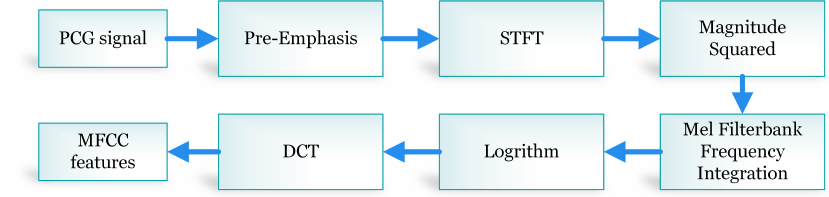
Figure 8. The process of mel-frequency cepstral coefficient (MFCC) feature